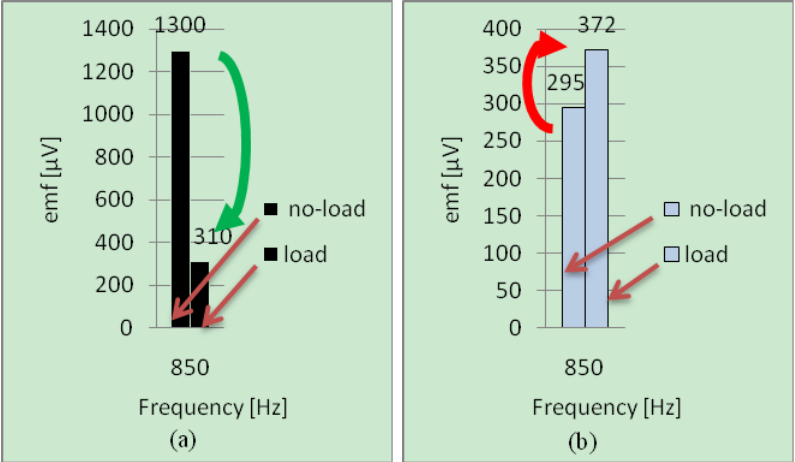
Figure 13. Harmonic components relative to 17 load operations for two positions of measurement: (a) Position 2; (b) Position